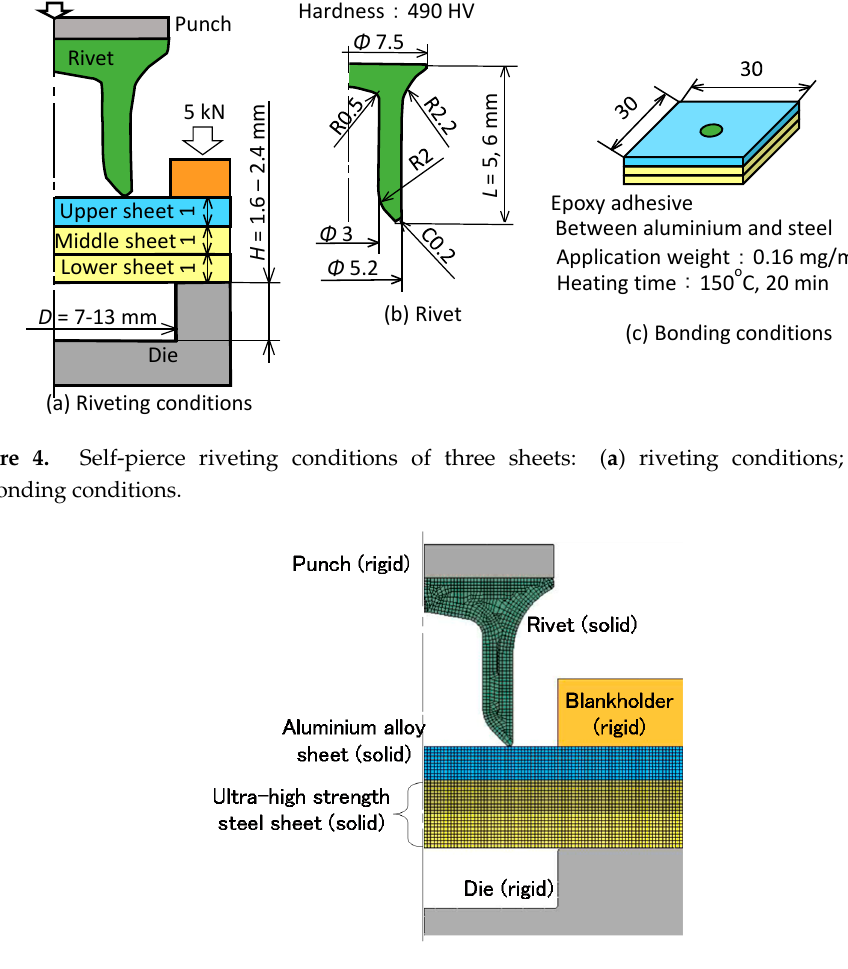
Figure 5. Conditions of simulation in self-pierce riveting for three sheets and for the upper aluminium alloy sheet.